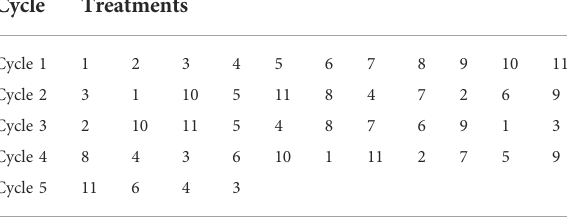
TABLE 2 Chronic unknown mild stress (CUMS)